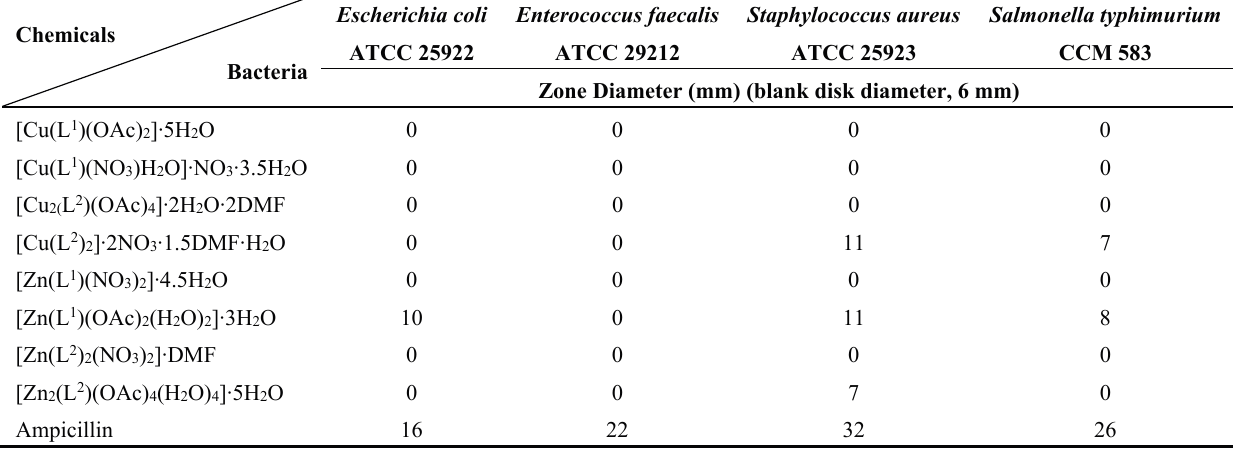
Table 2. Antibacterial activity against test bacteria of the novel cyclohexane-1,3-dione ligands and their metal